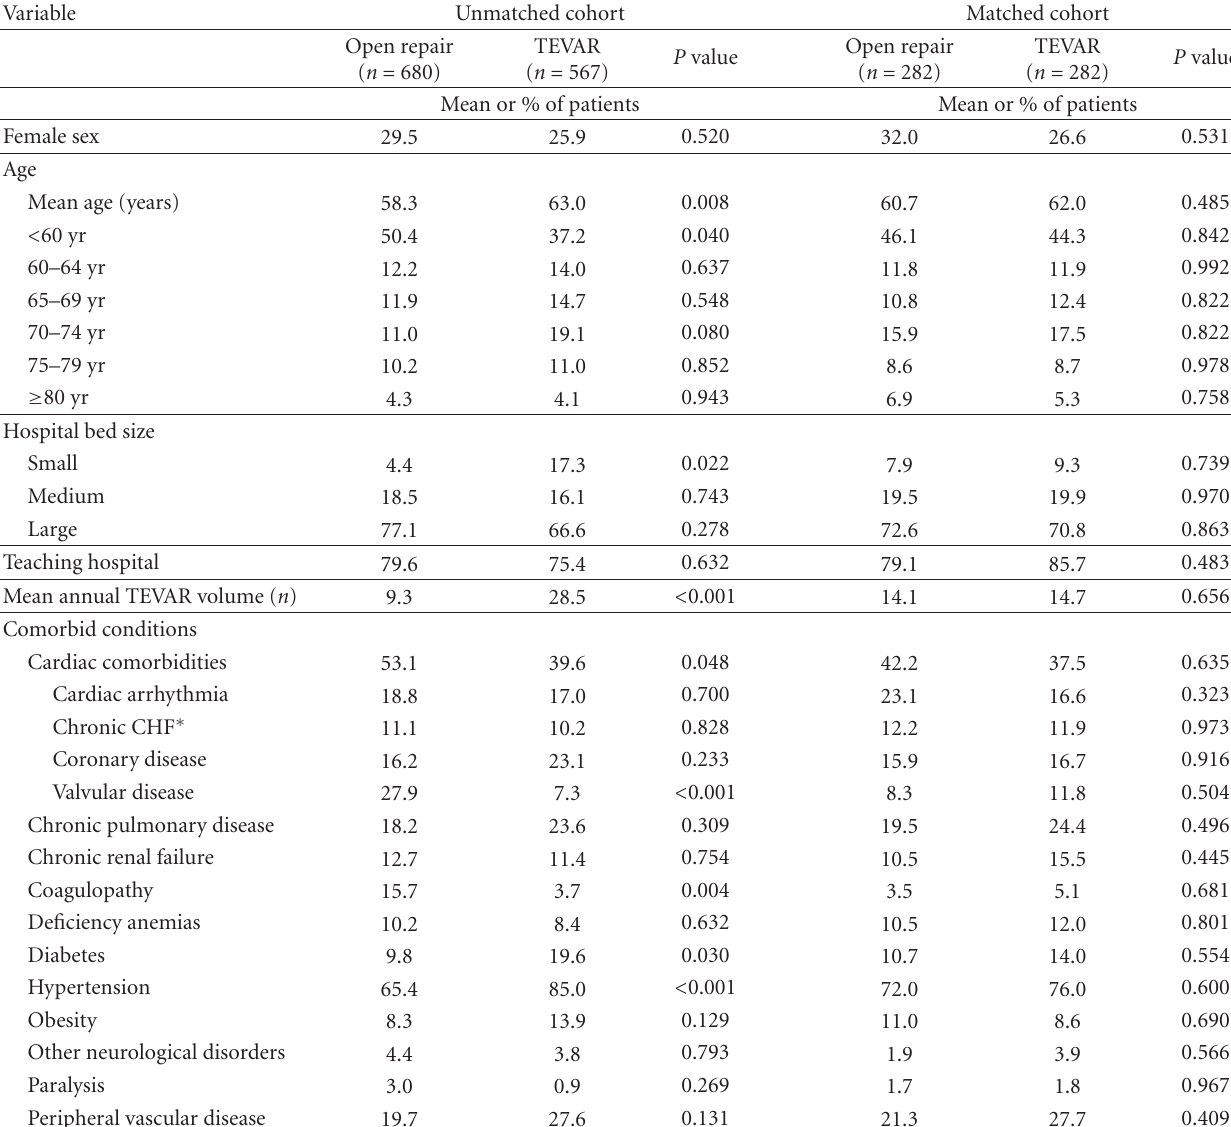
Table 3: Baseline characteristics of electively admitted patients undergoing open surgical repair or TEVAR for type B dissections from 2005 to